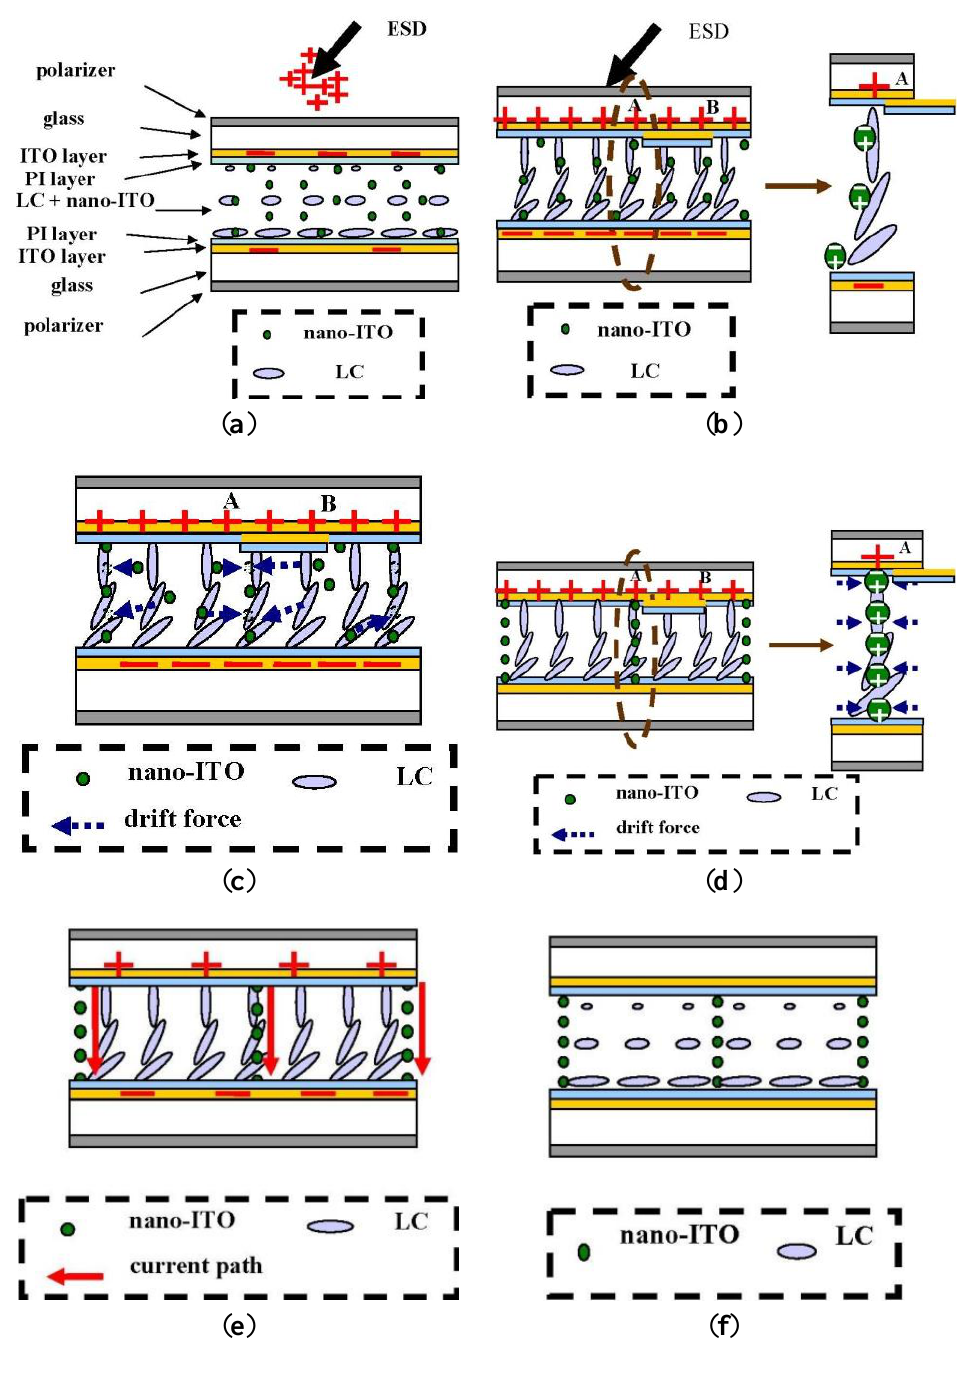
Figure 16. The hypothesized process for forming ITO bridges under high electric fields: ( a ) an HV gun approaches; ( b ) charges are induced by the HV gun; ( c ) non-uniform field intensity would cause ITO aggregates around the defected corners as at positions A and B in ( b ); ( d ) formation of ITO bridges after aggregation in ( c ); ( e ) the conductive bridges offer paths to release the induced charges in the electrodes; ( f ) after releasing the charges, the LC directors return to their TN state; ( g ) without the existence of a strong electrical field, the ITO particles begin to diffuse outwards from the bridges; ( h ) upon reaching the thermal equilibrium state, the ITO particles distribute randomly in the